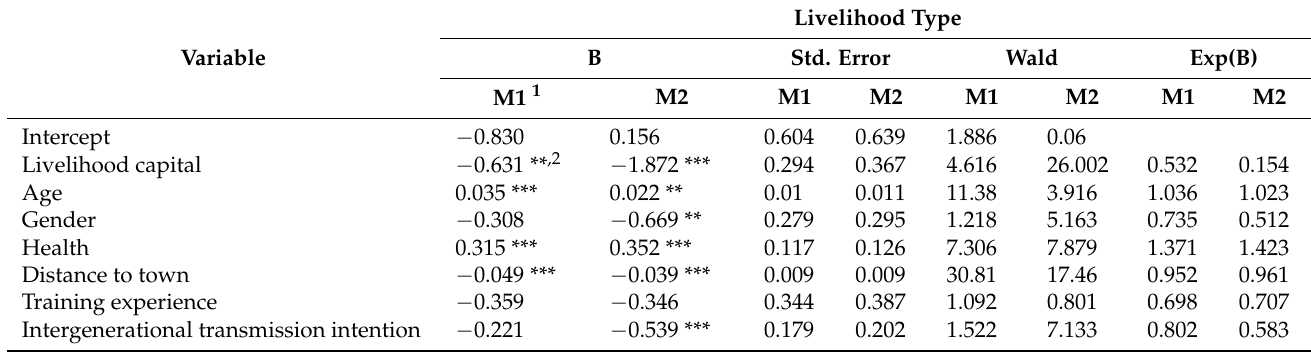
Table 2. Results of the impact of livelihood capital on livelihood